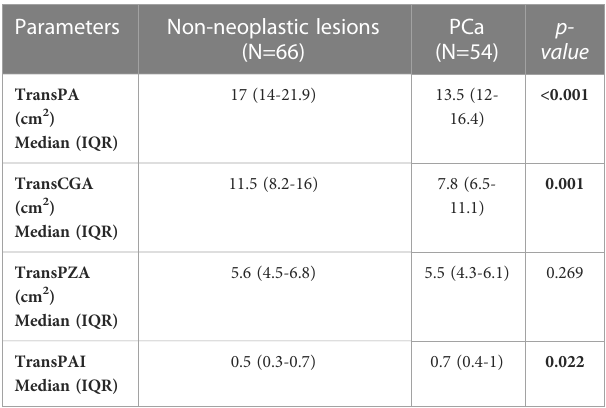
TABLE 2 Parameters measured on